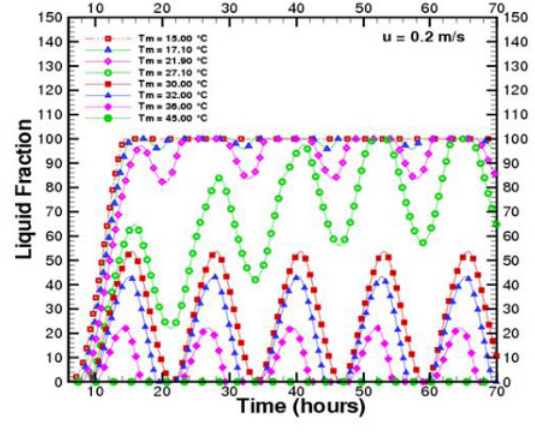
Fig. 3. Time evolution of the PCM liquid mass fraction for different PCM melting temperatures (sinusoidal inlet